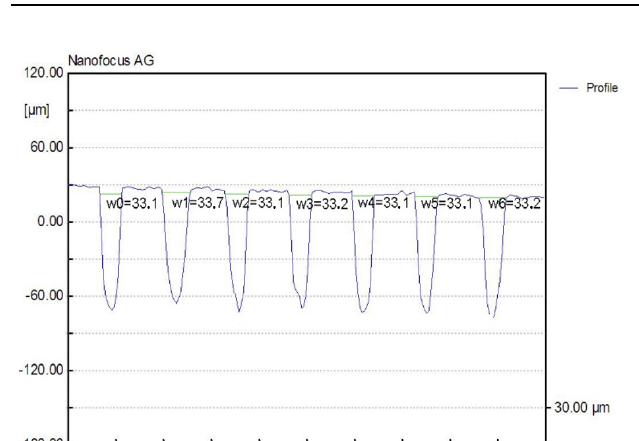
Figure 9. Rectangular microchannels used for laminating the HFC-R134a coolant, scale in µm.